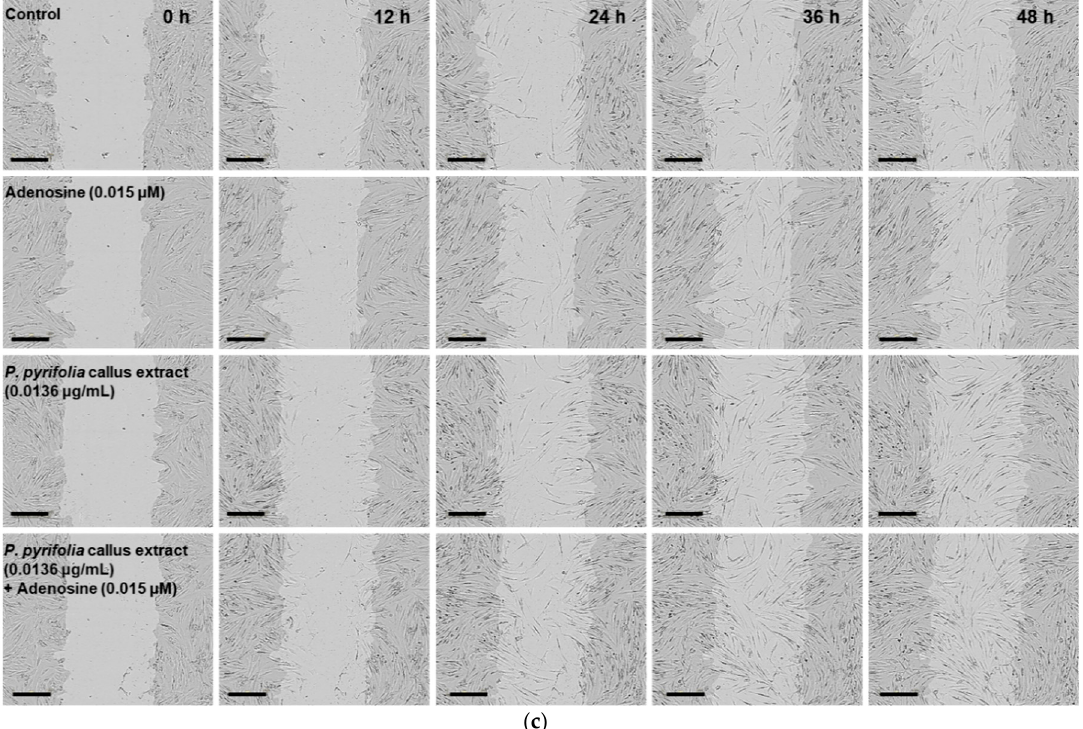
Figure 7. Relative scratch wound recovery of CCD-986sk cells after incubation with adenosine and P. pyrifolia callus extract. ( a ) Relative scratch wound recovery of CCD-986sk cells after 36 h. ( b ) Time course of relative scratch wound recovery area of CCD-986sk cells. ( c ) Representative microscopic images of scratch wounds after treatment with serum-free medium (control), adenosine (0.015 µM), or P. pyrifolia callus extract (0.0136 µg/mL) alone or in combination with adenosine (0.015 µM). Values are means ± standard deviation ( n = 6). * p < 0.05, ** p < 0.01, *** p < 0.001 compared to the untreated control. # p < 0.05 compared to adenosine alone (0.015 µM). $$ p < 0.01, $$$ p < 0.001 compared to P. pyrifolia callus extract alone (0.0136 µg/mL). Scale bar in ( c ): 300 µm.